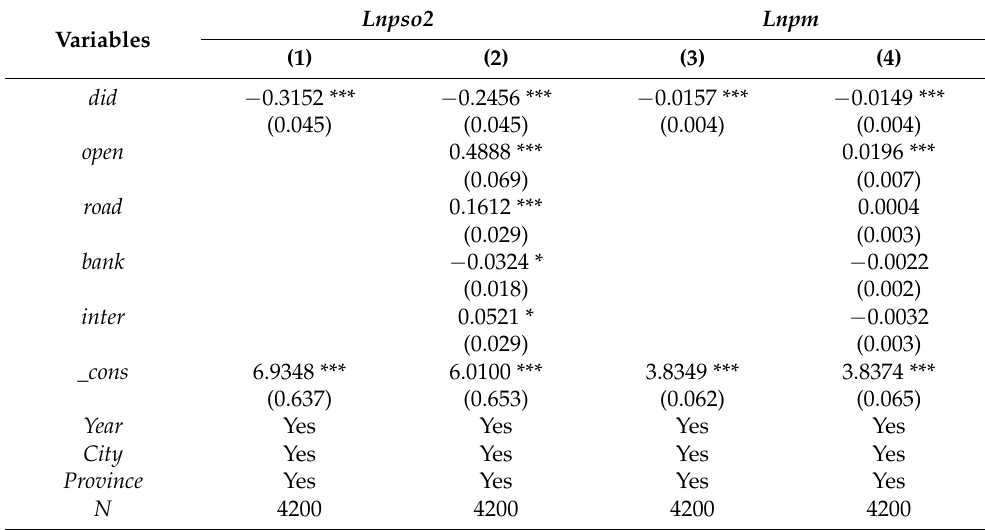
Table 2. Baseline regression